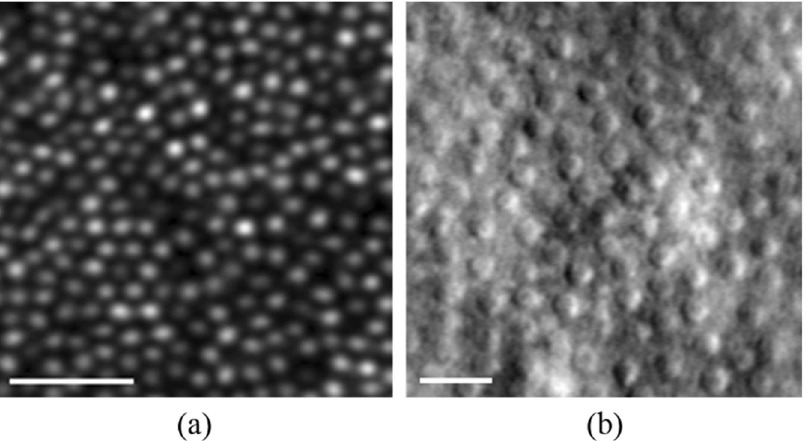
Figure 1. AOSLO cone imaging. ( a ) Confocal AOSLO image at 0.65° from the fovea. ( b ) Split detector AOSLO image at approximately 8° from the fovea. Scale bars : 20 μ m.